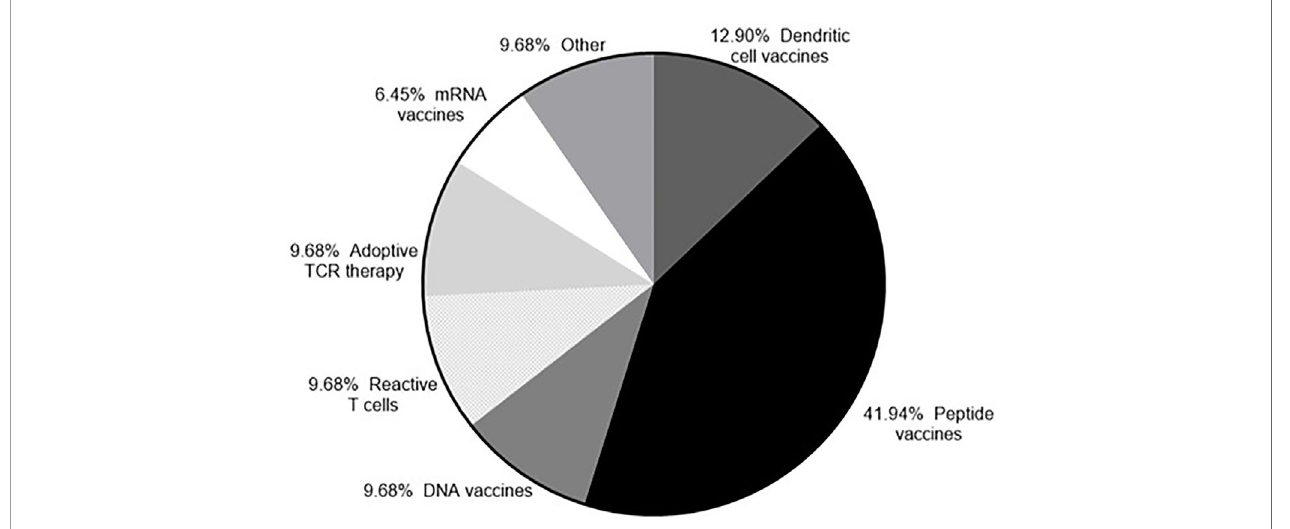
FIGURE 3 | Neoantigens currently in clinical trial. According to clinicaltrials.gov (as of 23 rd September 2020) there are currently 33 clinical trials recruiting that target